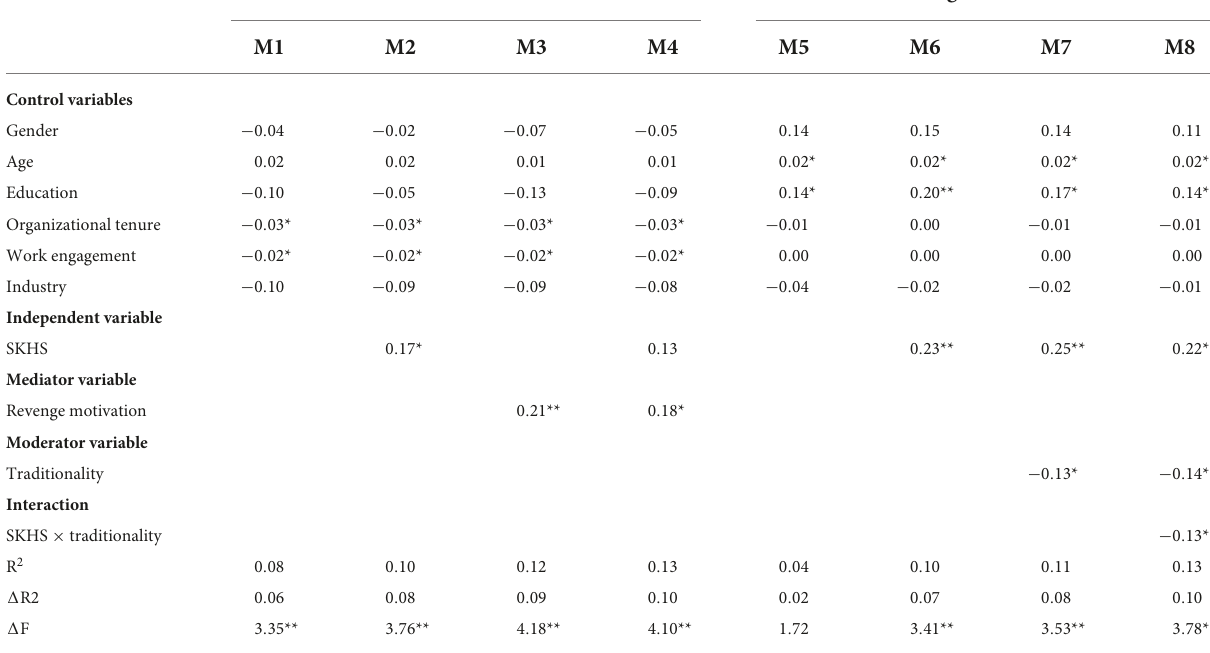
TABLE 3 The results of hierarchical regression